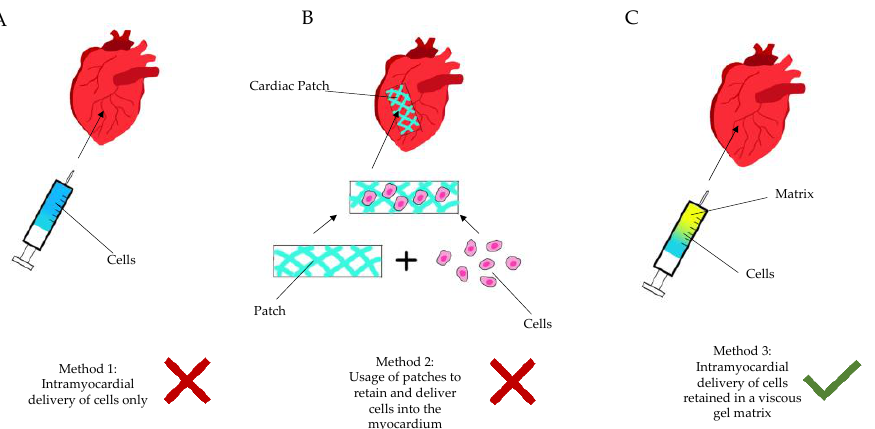
Figure 2. Diagram showing the current methods of regenerative cardiac therapy. ( A ): Method 1—intramyocardial delivery (injection) of stem cells only, without a retaining matrix. ( B ): Method 2—seeding of cells into a patch-like matrix, which is then implanted onto the epicardium via sutures or glue. ( C ): Method 3—intramyocardial injection of cells/active ingredient retained in a gel matrix, either during an open surgery (thoracotomy) or in a minimally invasive manner (percutaneously, etc.).